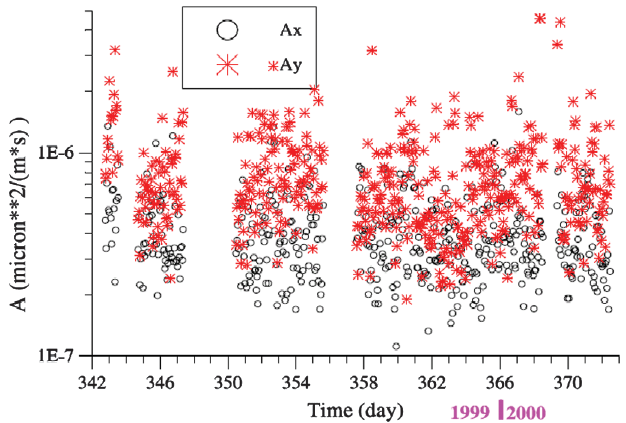
24. (Color) Diffusion coefficient A as measured from